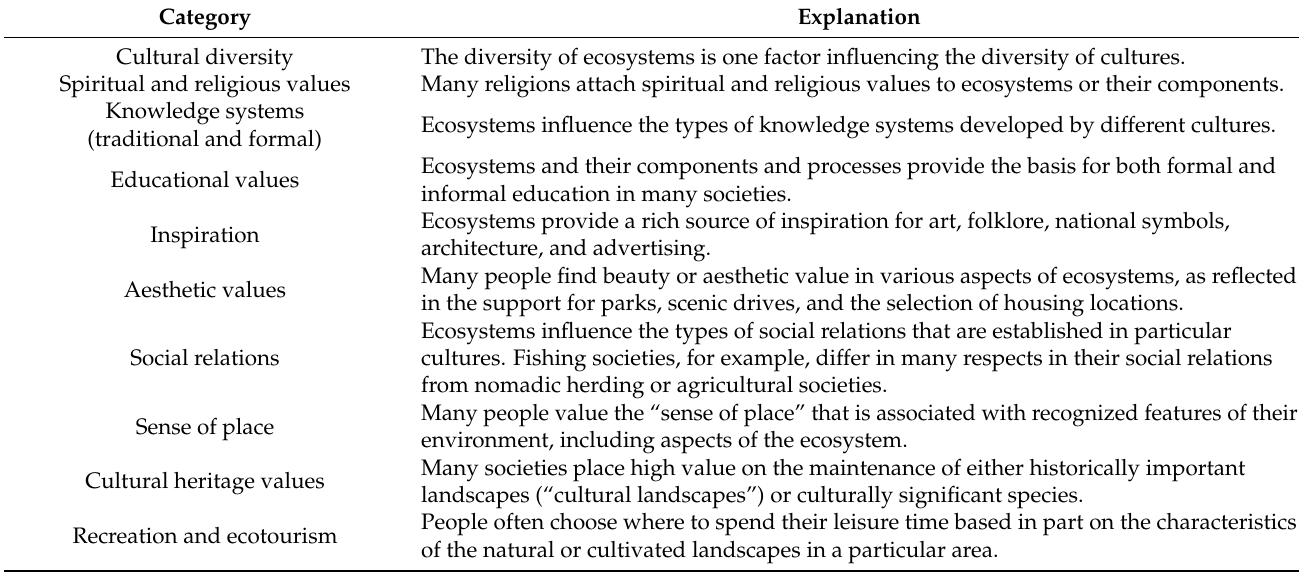
Table 1. The categories and their explanations of cultural ecosystem services by MA (listed from [12]). Category Explanation Cultural diversity The diversity of ecosystems is one factor influencing the diversity of cultures. Spiritual and religious values Many religions attach spiritual and religious values to ecosystems or their